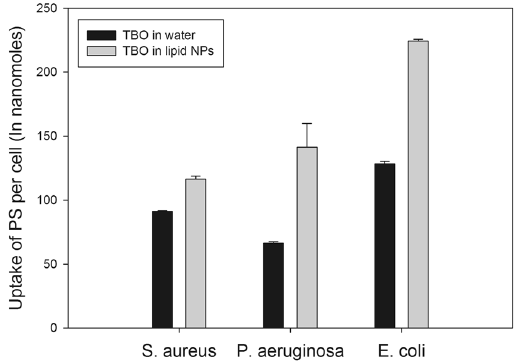
Figure 6. Uptake of photosensitizer molecules in bacterial cells of each type of strain expressed as the nano moles of photosensitizer per bacterial cell. Usage of lipid nanoparticles for encapsulating TBO enhanced the cellular uptake of photosensitizer as compared to usage of only TBO in water. Symbols like “ * ” indicate statistical significance between the groups of TBO in water and TBO in lipid nanoparticles; p < 0.05.